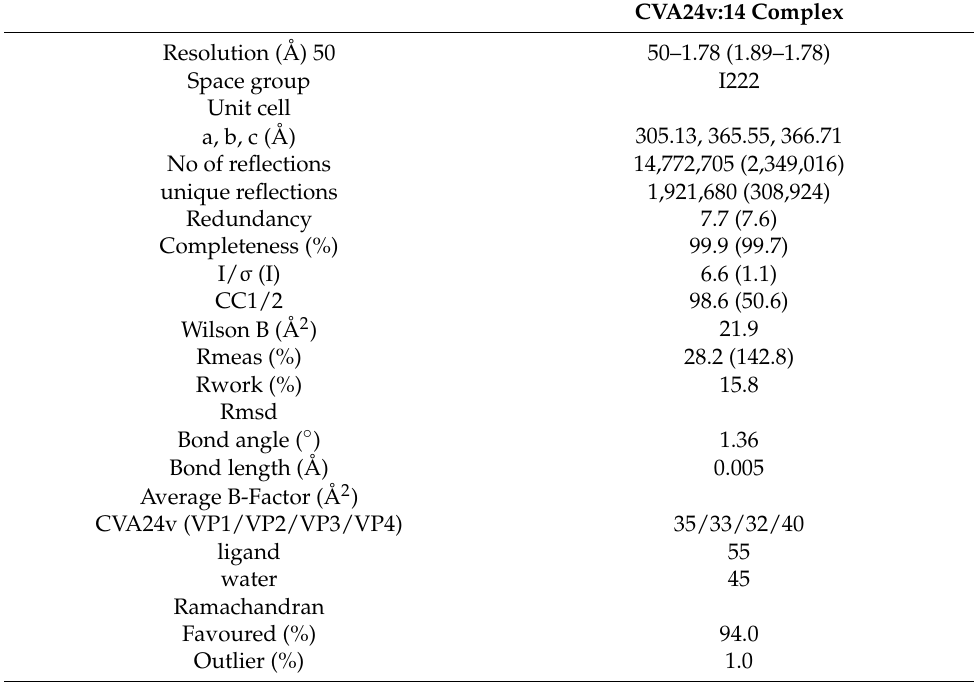
Table 1. Data collection and refinements statistics for CVA24v in complex with 14 . Values in parentheses are for the highest resolution shell.